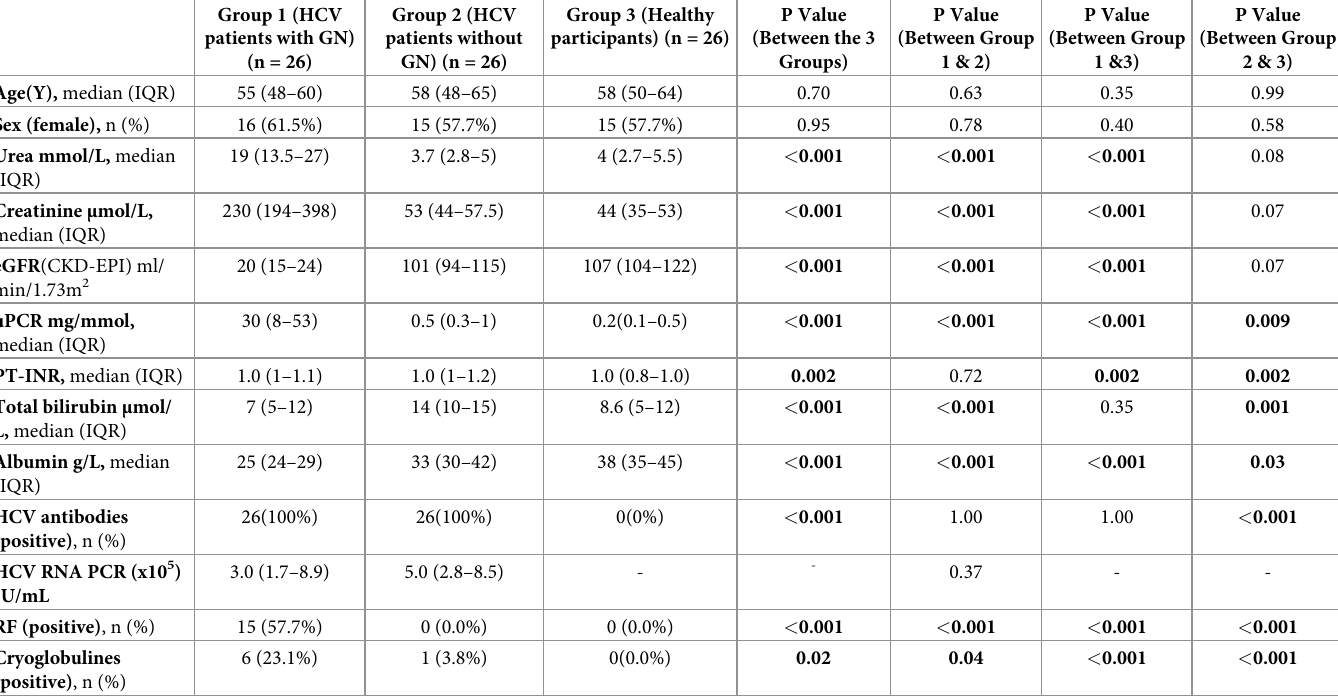
Table 1. Comparison between the studied groups according to the clinical and biochemical characteristics. Group 1 (HCV patients with